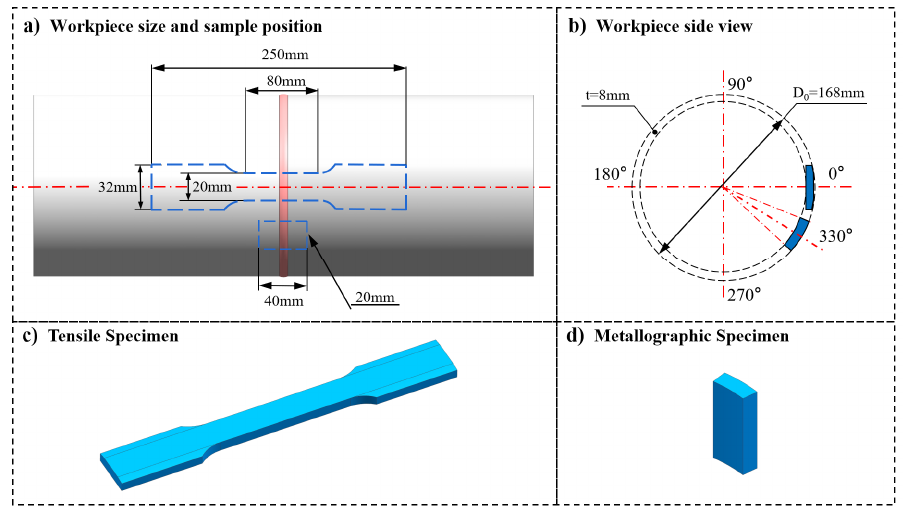
Figure 7. Test sampling location and size specification.